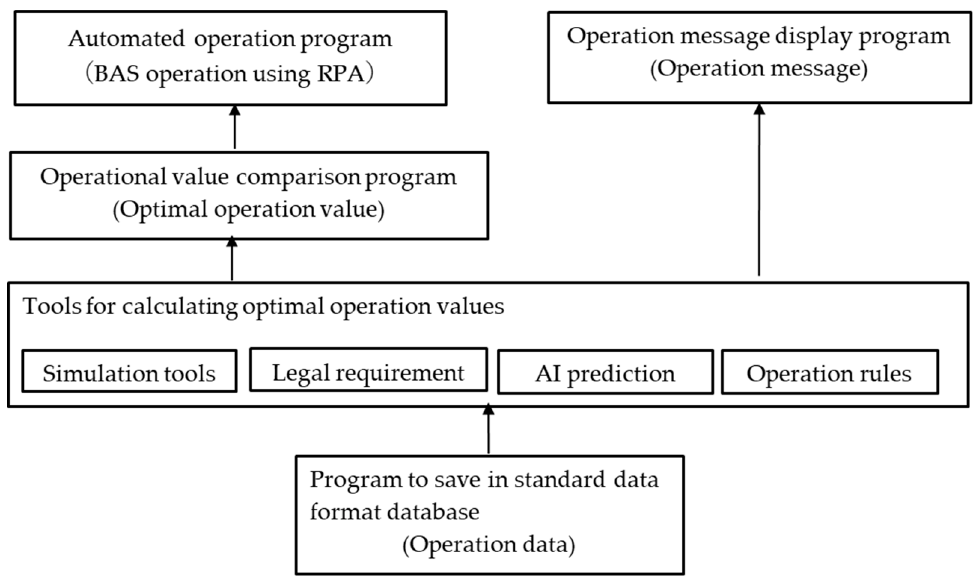
Figure 2. Software configuration.